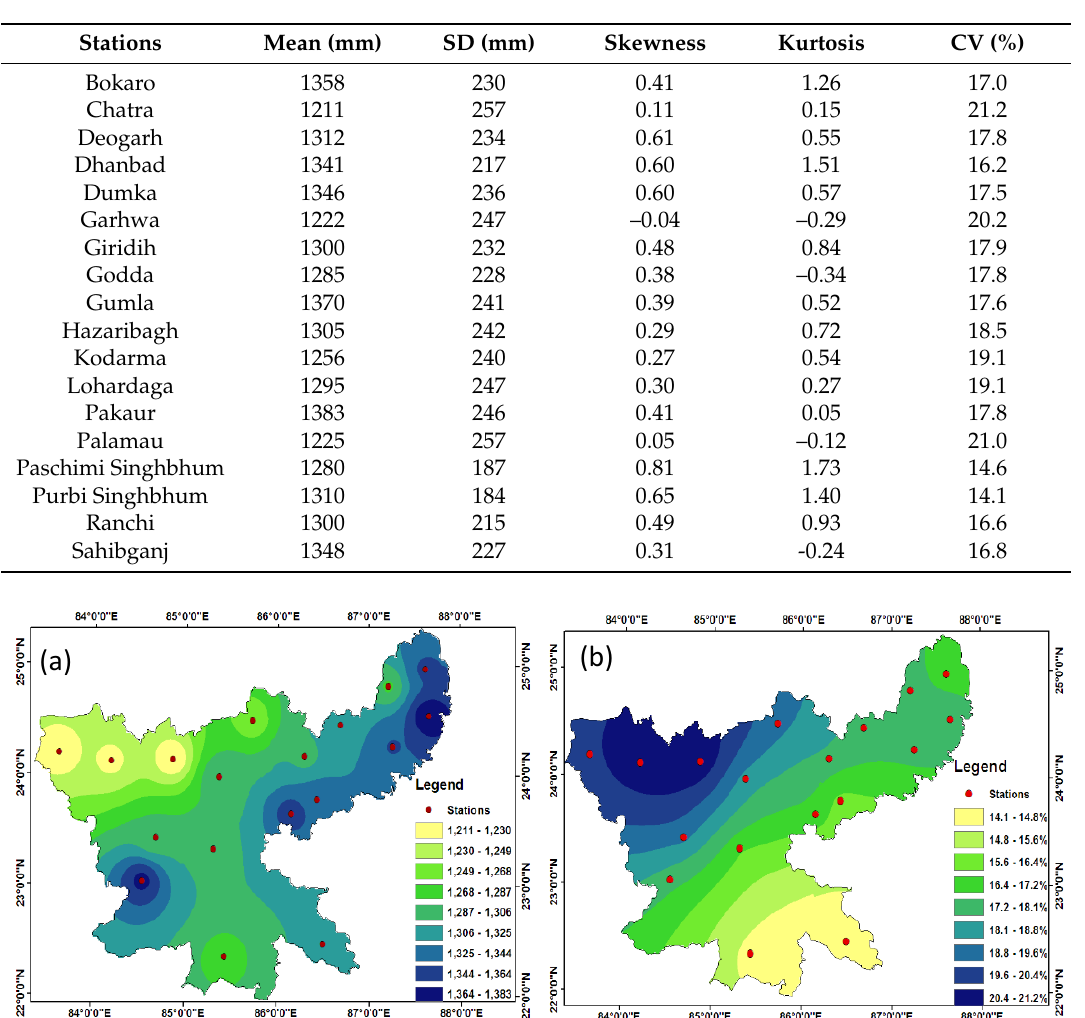
Table 1. Statistical Analysis of rainfall (mm) over the study area.